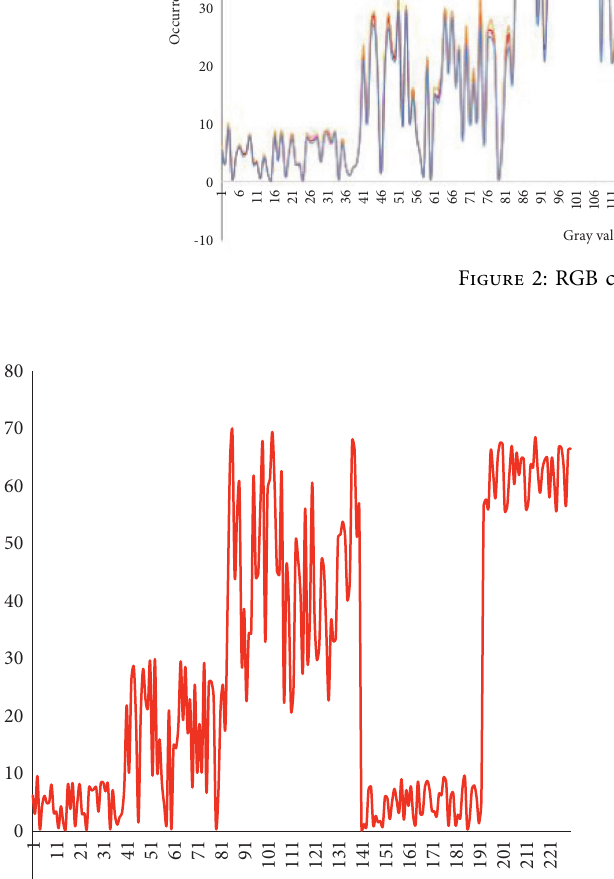
Figure 3: Grayscale histogram.